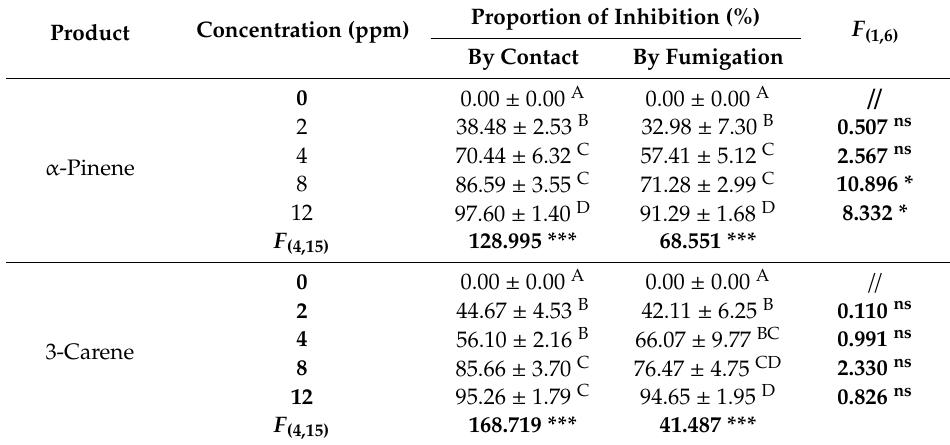
Table 5. Inhibition of development of Sitophilus zeamais immature stages due to treatment of stored maize with α -pinene and